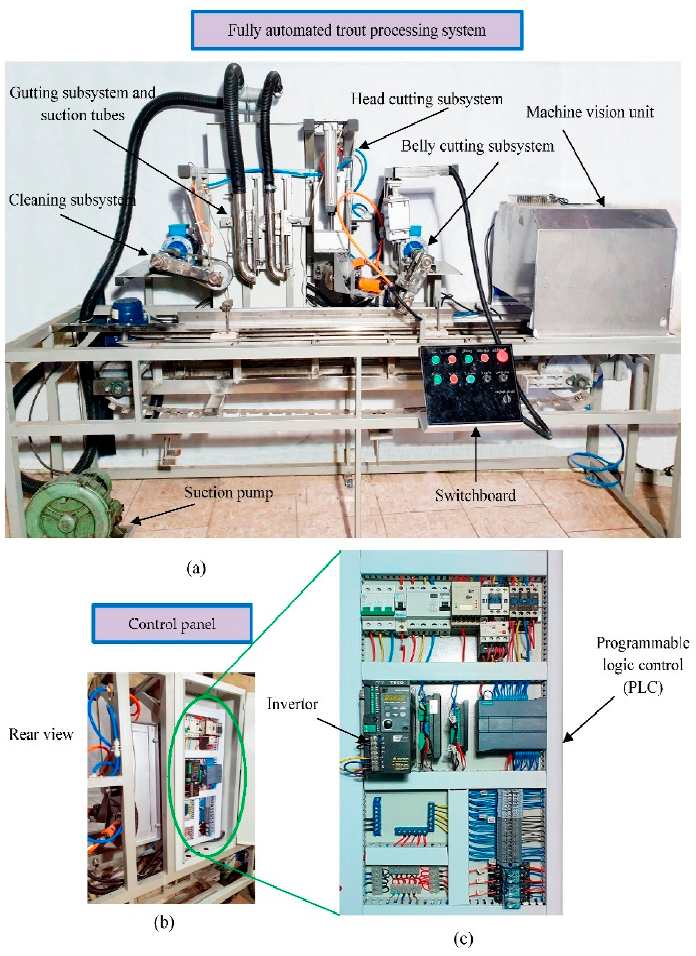
Figure 15. The fabricated trout-processing system: ( a ) the completed mechanical and electronics parts, ( b ) the rear view, and ( c ) controlling panel.